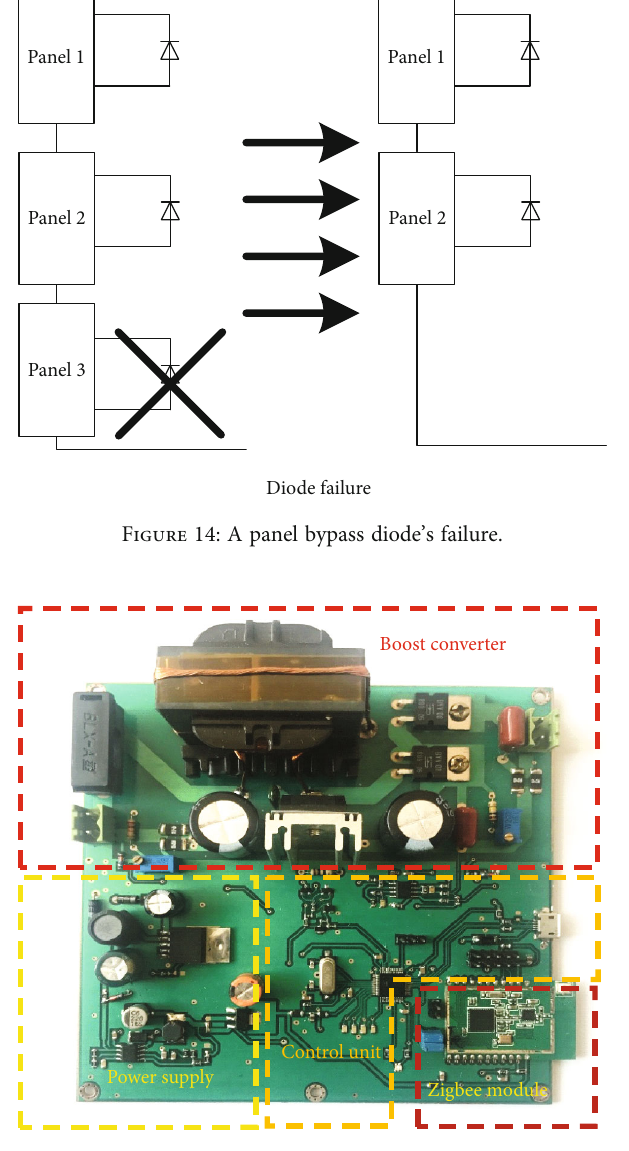
Figure 15: Boost